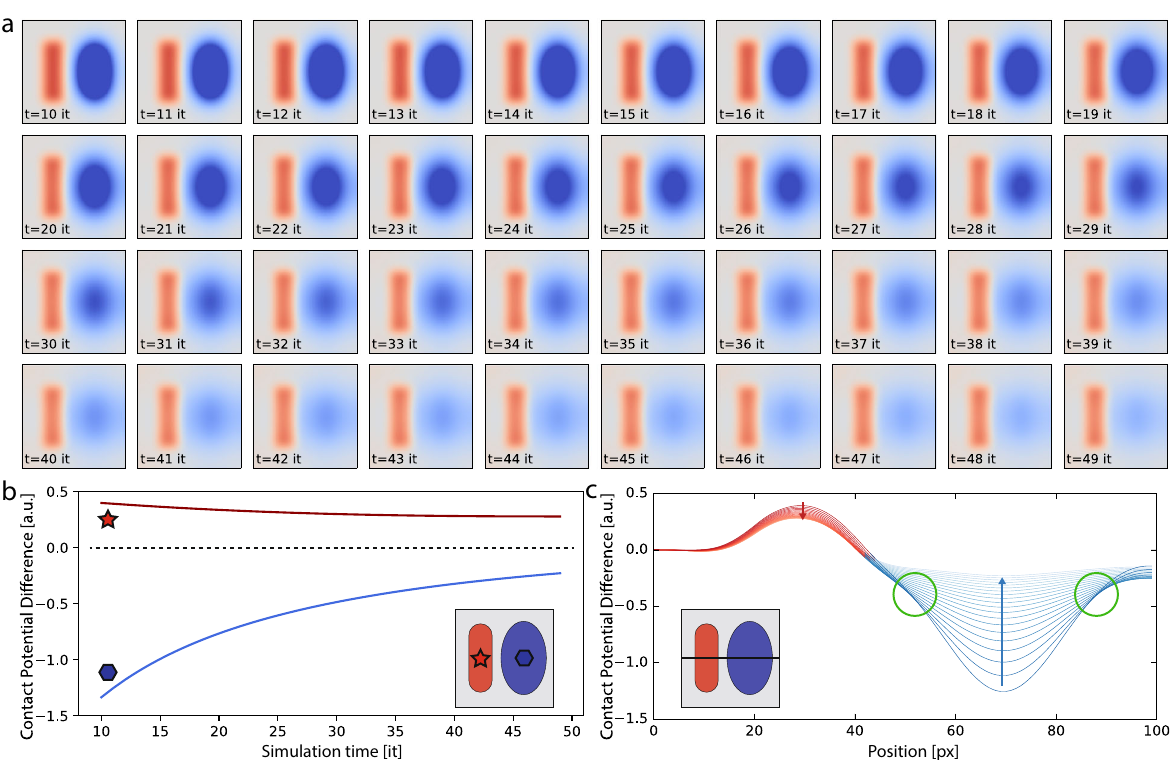
Fig. 4 FitzHugh – Nagumo reaction – diffusion model of the surface charge dissipation. a Time evolution of the positive (red) and negative (blue) surface charge distributions shows spatially localized vs. highly diffusive behaviour, qualitatively reproducing the experimental observations. Maxima ( b ) and cross-sections ( c ) of the positive and negative charge distributions show that both positive and negative charge intensities decay with time, but that only negative charges show a lateral diffusion, as evidenced by the increased width of the signal, leading to characteristic crossing points (green